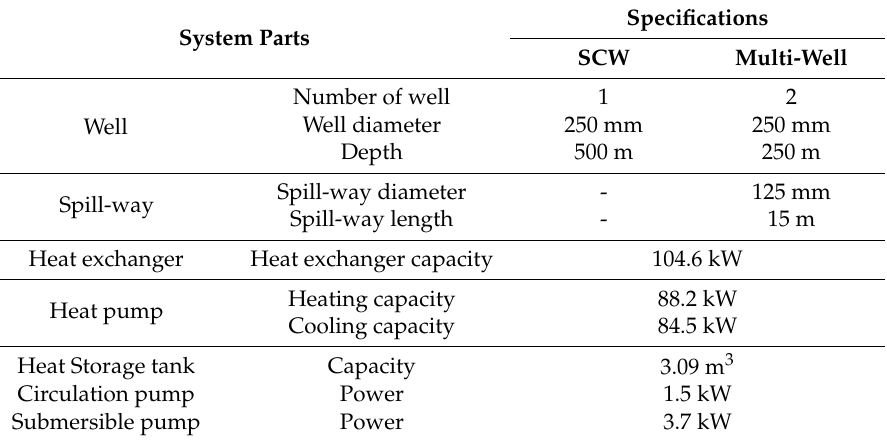
Figure 5. Schematic diagram. Table 4. System equipment specification.